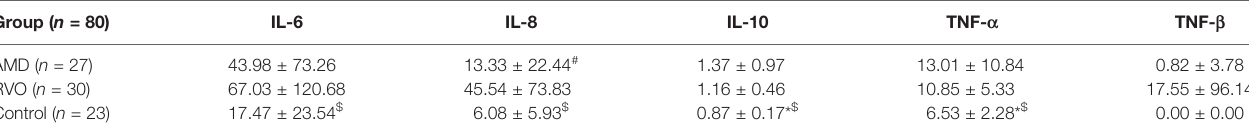
TABLE 3 | The levels of, IL-6, IL-8, IL-10, TNF- a , and TNF- b in the